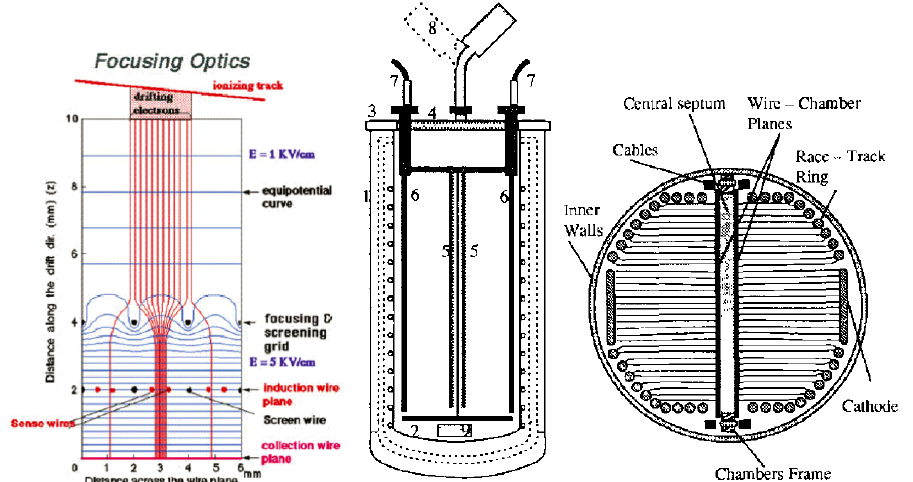
Figure 2. ( Left ): Electric field lines close to the wire chambers of the first small ICARUS LAr-TPC prototype. ( Center ): Sketch of the ICARUS 3 ton detector, with highlighted the outer vessel (1), the inner vessel (2), the annular flange (3), the circular flange (4), the wire chambers (5), the cathodes (6), the high voltage feed-throughs (7), the pre-amplifiers containers (8) and finally, the LAr purity monitor (9). ( Right ): Top view of the electric field lines along the drift region of the ICARUS 3-ton